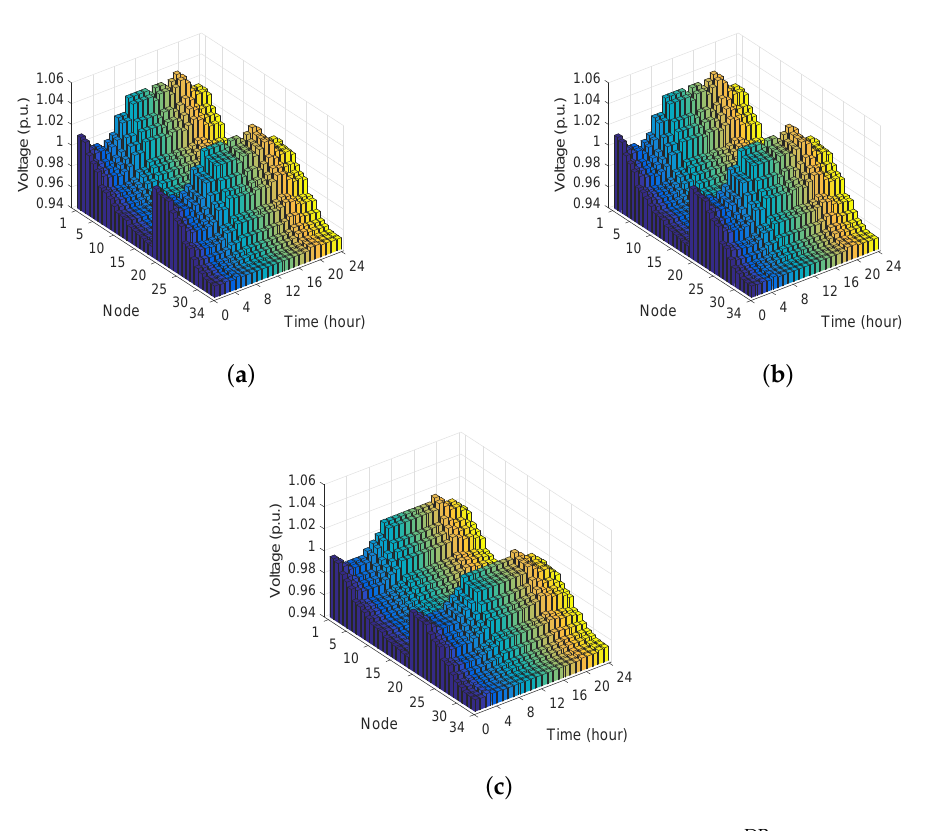
Figure 10. Voltage profiles with demand reduction for Case 3: ( a ) X DR = 0 (0% reduction); ( b ) X DR = 0.1 (10% reduction); ( c ) X DR = 0.2 (20%